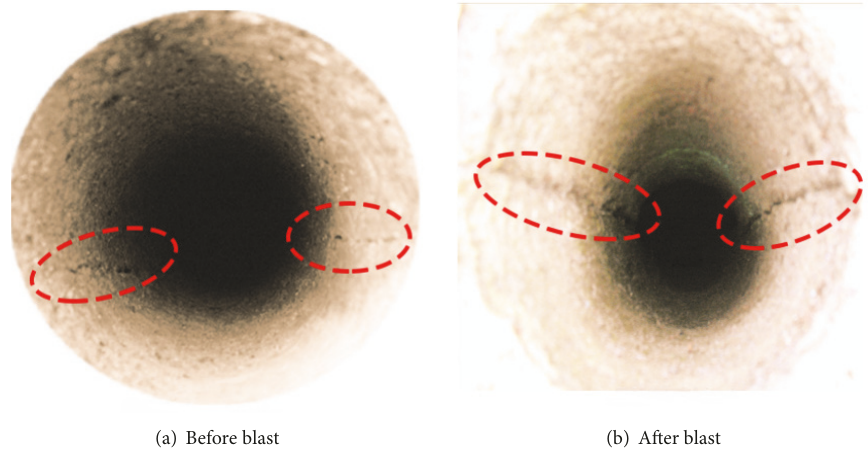
Figure 3: Photograph showing crack propagation in blasthole before and after multiblast.